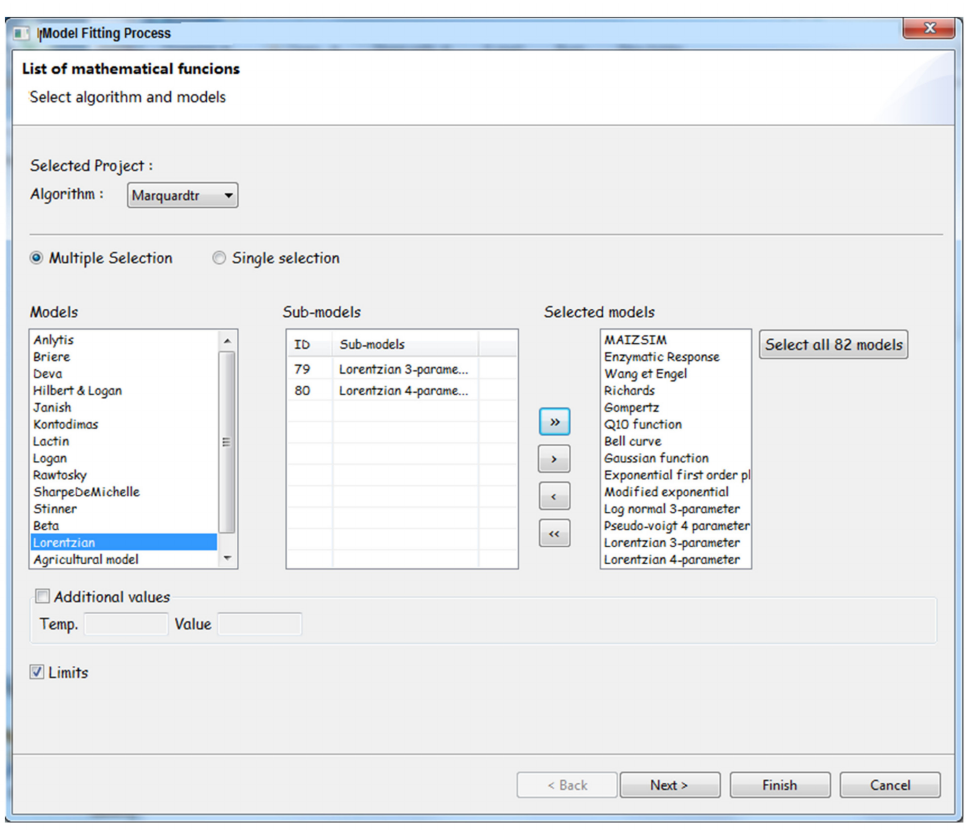
Figure 4. User interface (UI) for importing, plotting, and modifying experimental data.